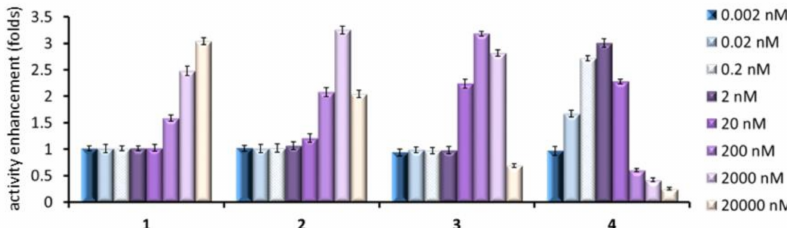
Figure 5. Mutant GCase activity enhancements in cultured human fibroblasts of N188S/G183W type 3 Gaucher patients promoted by the sp 2 -iminosugar candidates 1 – 4 at different concentrations. Each bar represents the mean ± standard error (SEM) of three determinations each done in